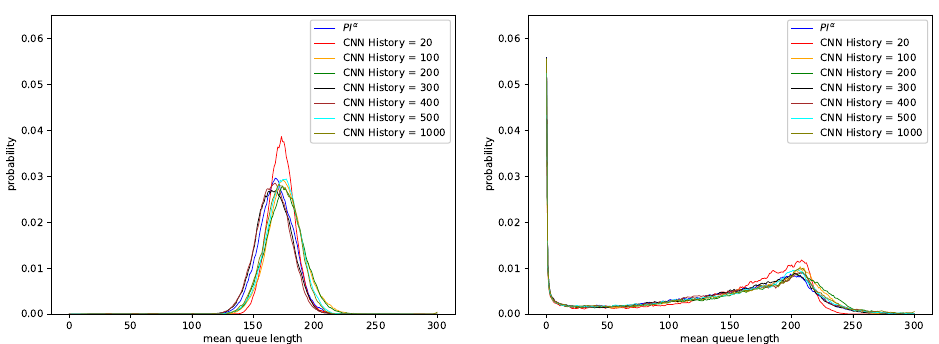
Figure 3. Distribution of queue length obtained for CNN model with the last layer activation function Sigmoid, trained using data regarding PI α 1 controller and parameters: K P = 0.0001, K I = 0.0004, α = − 0.4, H = 0.5 ( left ), H = 0.9 ( right ).